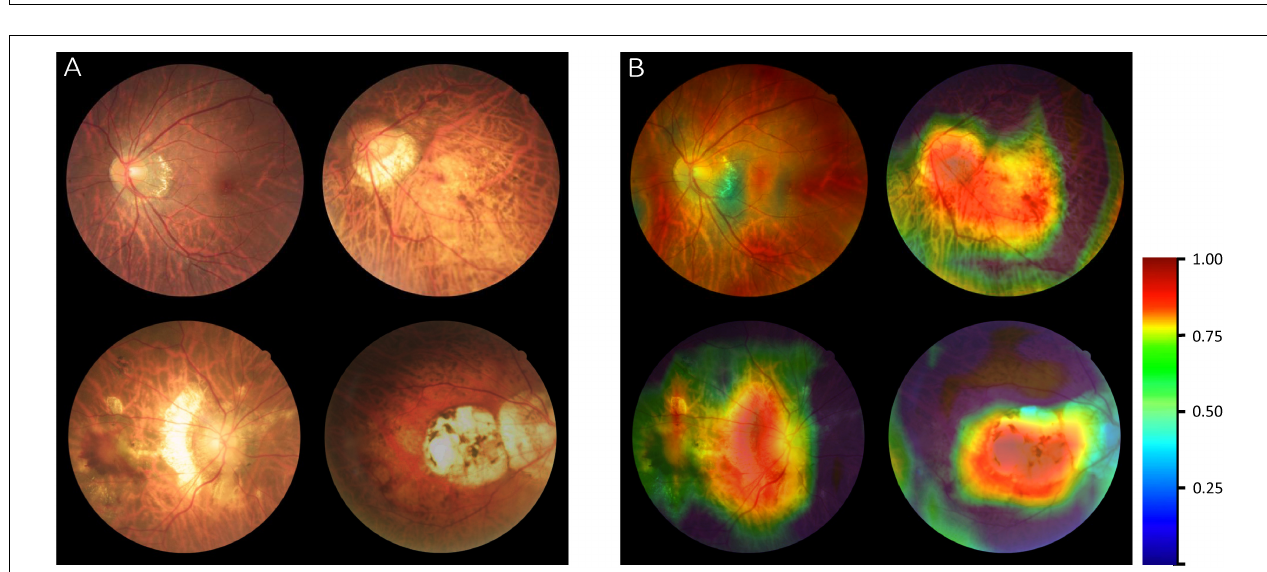
FIGURE 3 | The comparison between deep learning algorithms/AI-models and experts on accuracy in external validation.